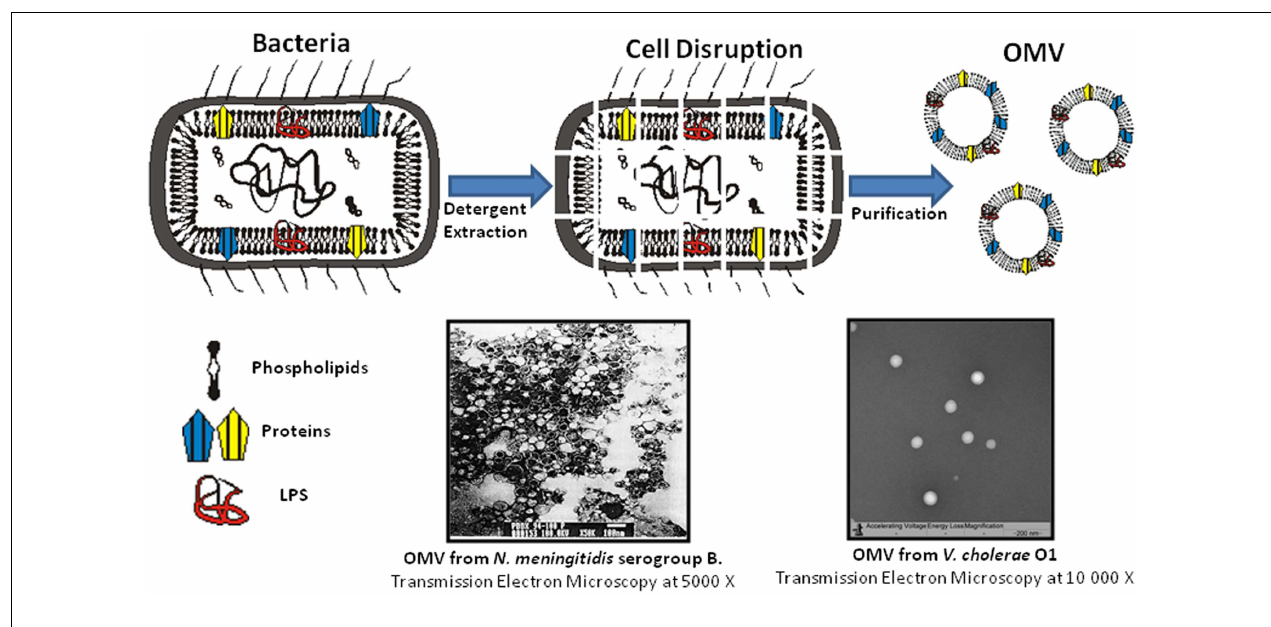
OMV from V. cholerae O1 extracted with sodium dodecyl sulfate (37). OMV have a similar size and vesicle like structure. Differences observed between micrographs are mainly due to changes in magnification and stains